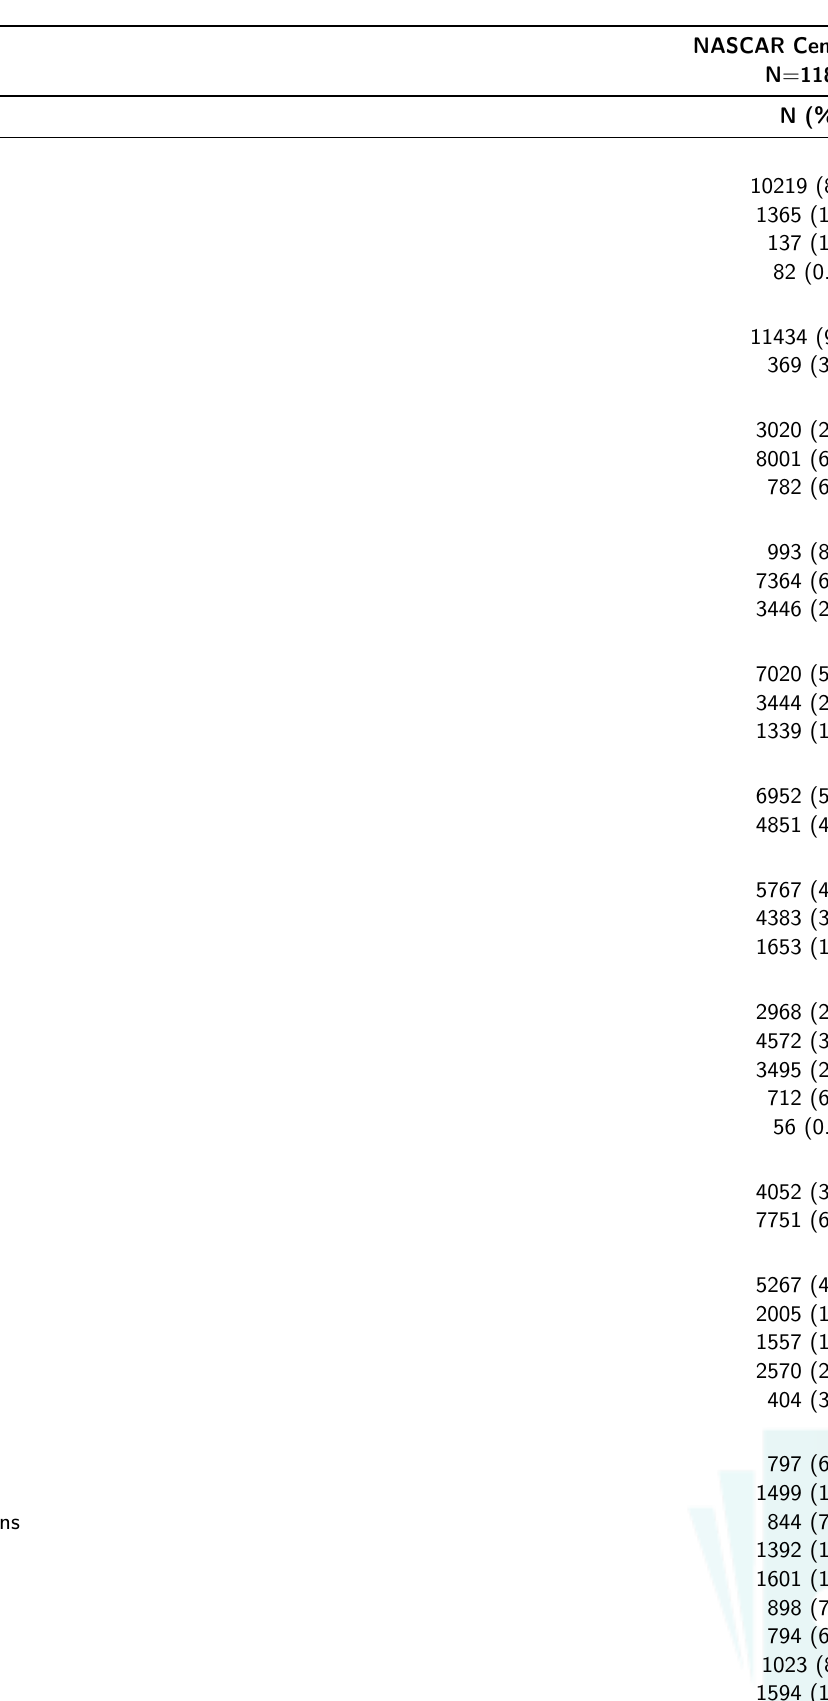
Table 2: Census characteristics of NASCAR Census